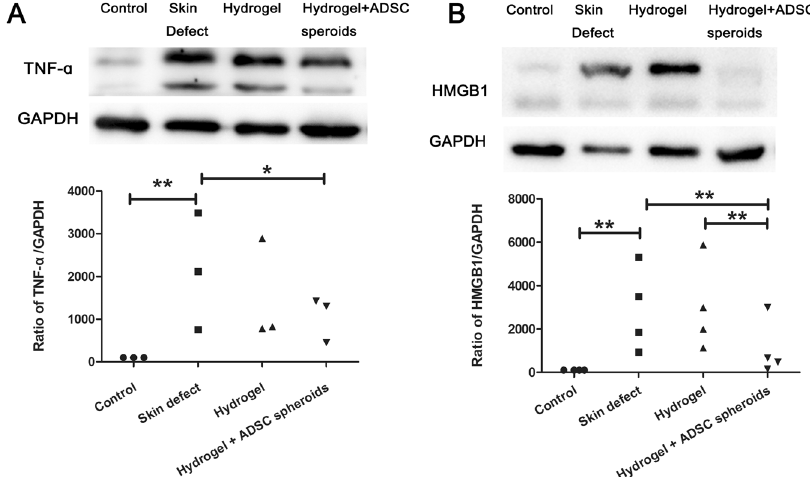
Fig. 7 DA-MeHA hydrogel-encapsulated spheroids composed of ADSCs downregulated in fl ammatory responses. A DA-MeHA hydrogel- loaded spheroids composed of ADSCs downregulated the expression of TNF- α . B DA-MeHA hydrogel-loaded spheroids composed of ADSCs downregulated the expression of HMGB1. n = 4 samples/group (* p < 0.05 and ** p < 0.01).